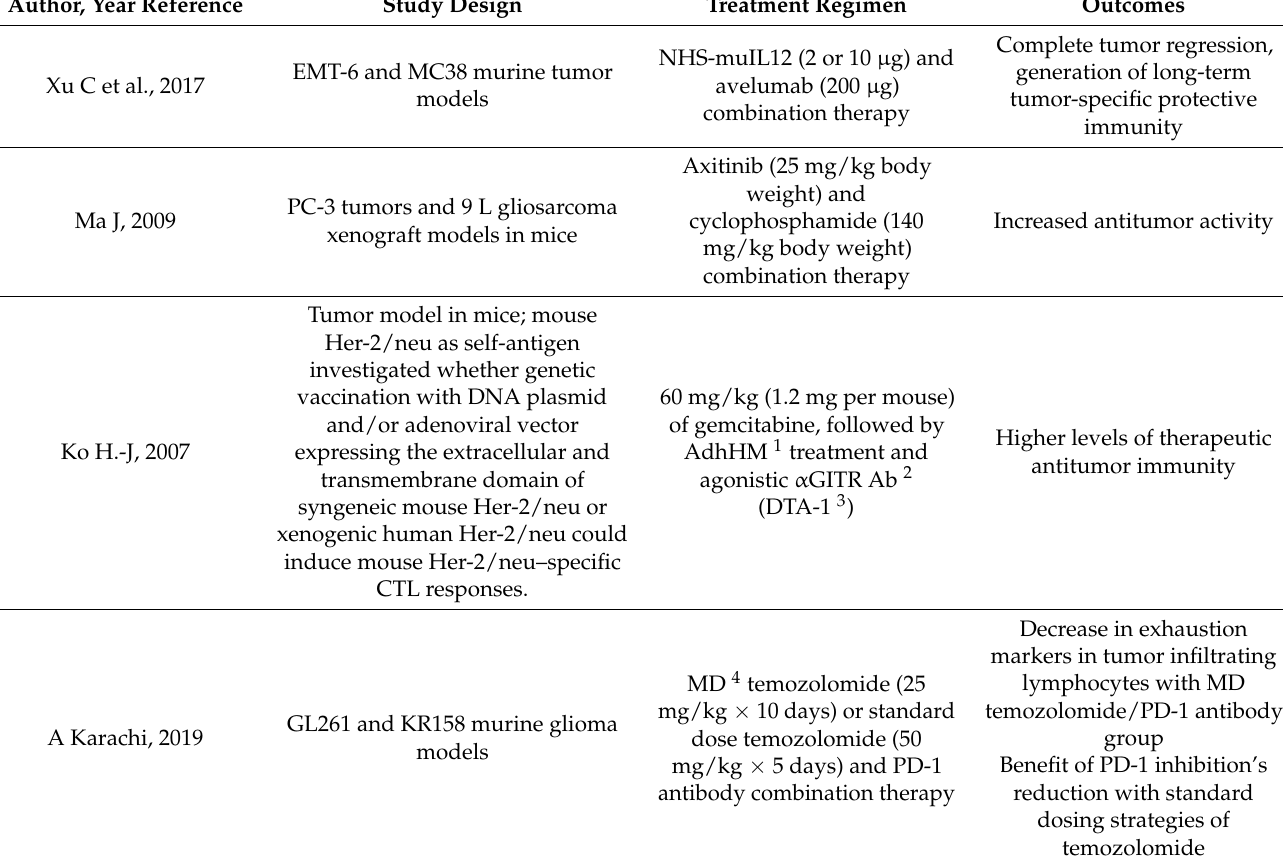
Table 1. Synergistic effect of immunotherapy and metronomic therapy. Preclinical